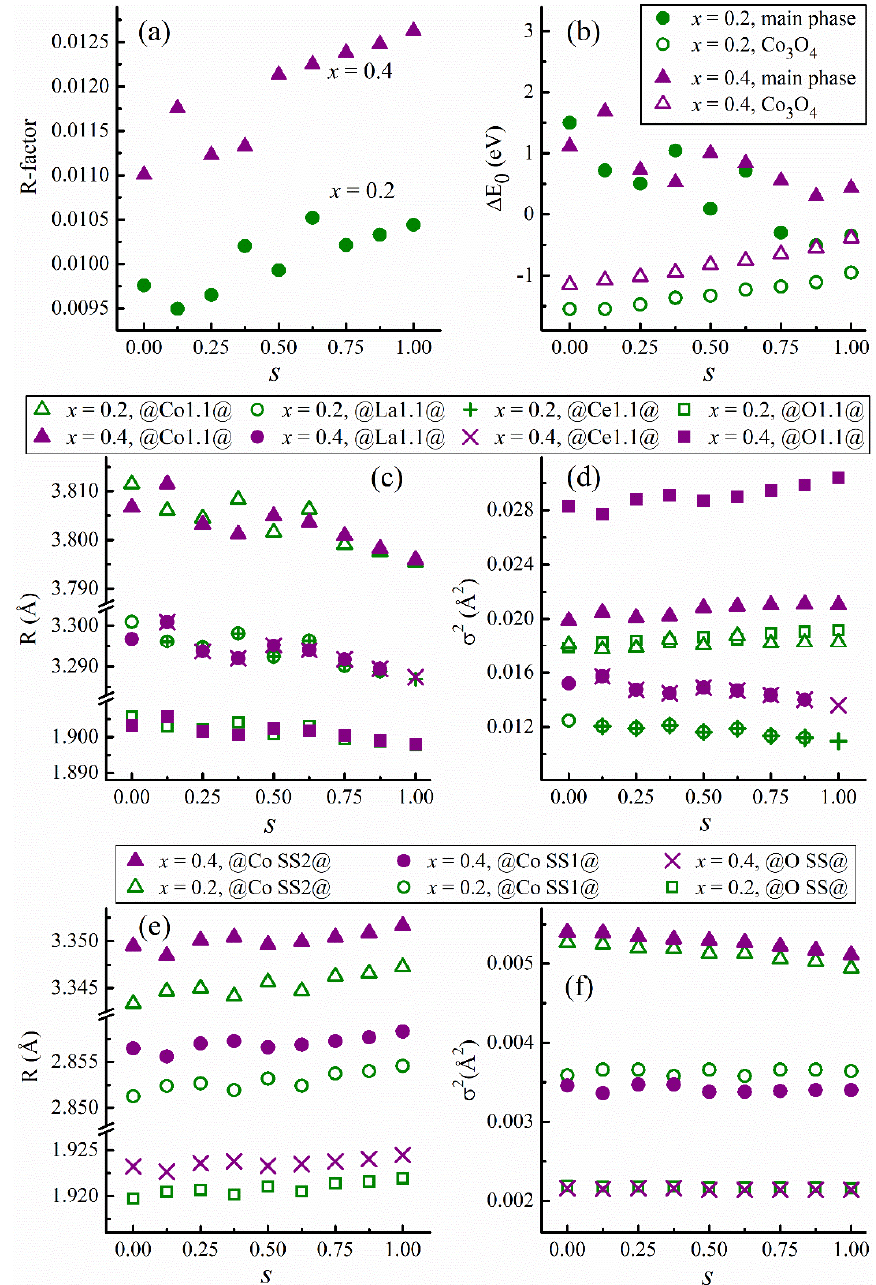
Figure 12. Fit indices and fitted parameters as a function of s , the fraction of cerium dopants in the cubic main phase, for EXAFS data of La 1 − x Ce x CoO 3 , with x = 0.2, and 0.4. ( a ) R -factor. ( b ) △ E 0 . ( c , d ) respectively show the values for radial distance and σ 2 for scattering paths of the main scattering phase. ( e , f ) respectively show the values for radial distance and σ 2 for scattering paths of the Co 3 O 4 -like scattering phase.